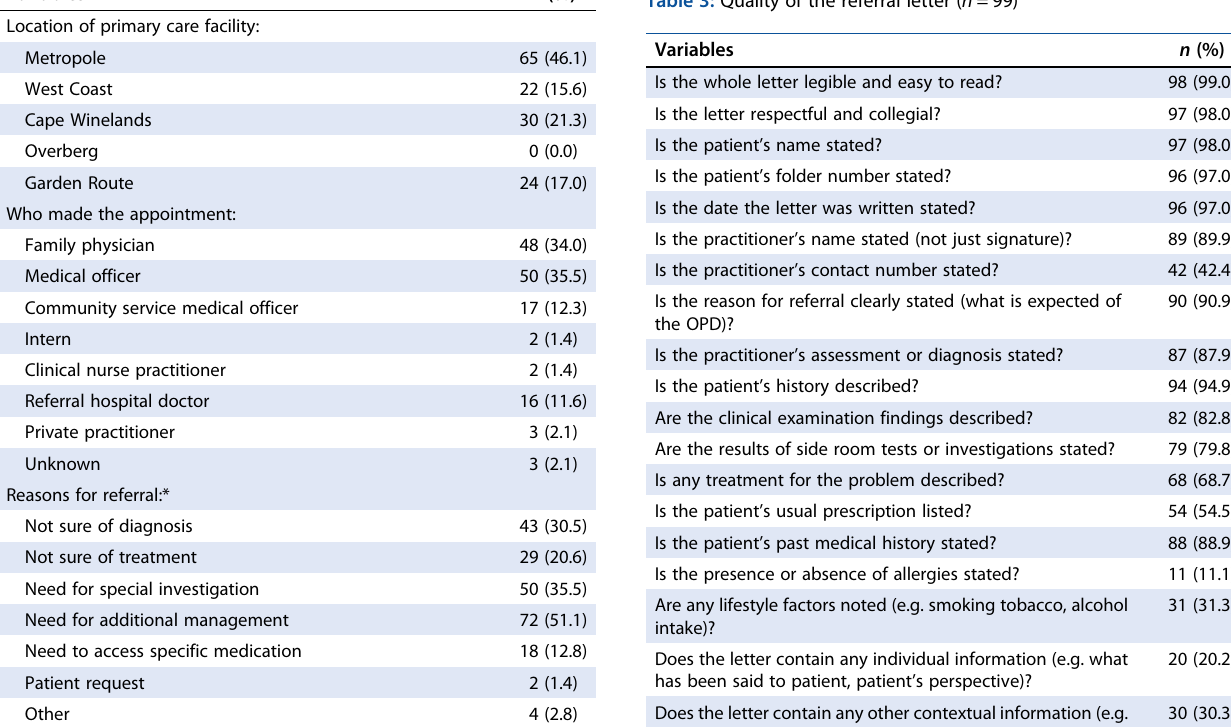
Table 3: Quality of the referral letter ( n =